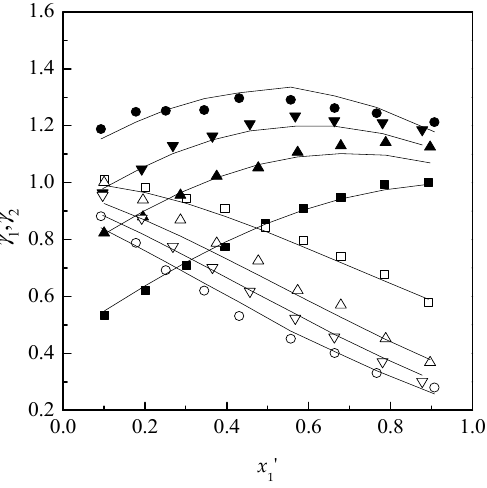
Figure 5. γ 1 ( γ 2 )- x 1 ′ diagram for ethyl acetone (1) + chloroform (2) + [MMIM][DMP] (3) at 101.32 kPa: ■ γ 1 - x 1 ′ , □ γ 2 - x 1 ′ , x 3 = 0; ▲ γ 1 - x 1 , △ γ 2 - x 1 ′ , x 3 = 0.10; ▼ γ 1 - x 1 ′ , ▽ γ 2 - x 1 ′ , x 3 = 0.15; ● γ 1 - x 1 ′ , ○ γ 2 - x 1 ′ , x 3 = 0.20; Solid line, calculated using NRTL model.